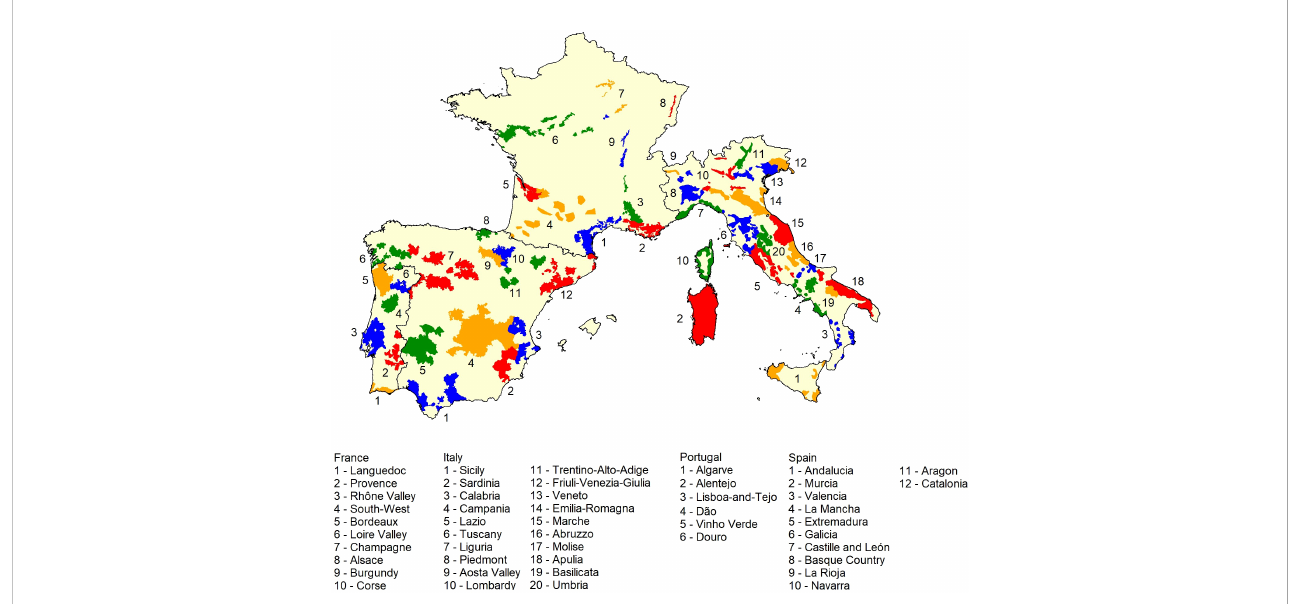
FIGURE 1 Study area and its main vinicultural zones (Fraga et al., 2020; Yang et al., 2022). Colors were used for distinctive purposes